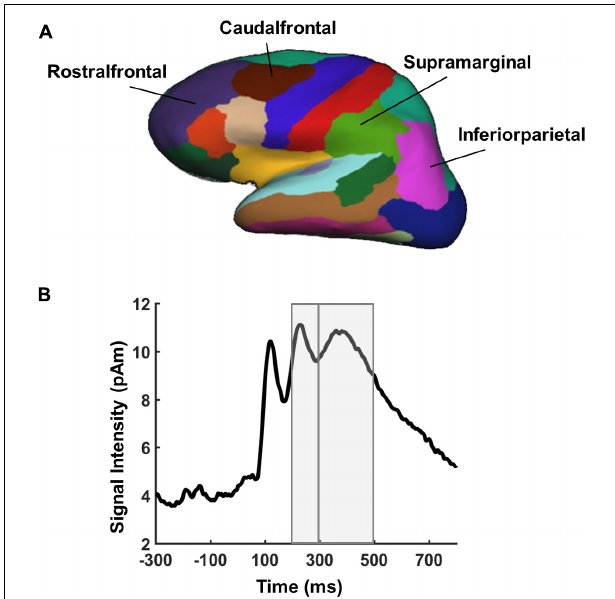
FIGURE 3 | Regions and time windows of interest for EEG source analyses. (A) Bilateral frontal and bilateral parietal parcellations of the cortical surface created by neuroanatomical labels of the Freesurfer software based on the Desikan-Killiany Atlas (Desikan et al., 2006). (B) Overall activation time courses in evoked source estimates averaged across all vertices and task conditions of interest (targets, lures, and fillers). Gray areas indicate the time windows used for statistical